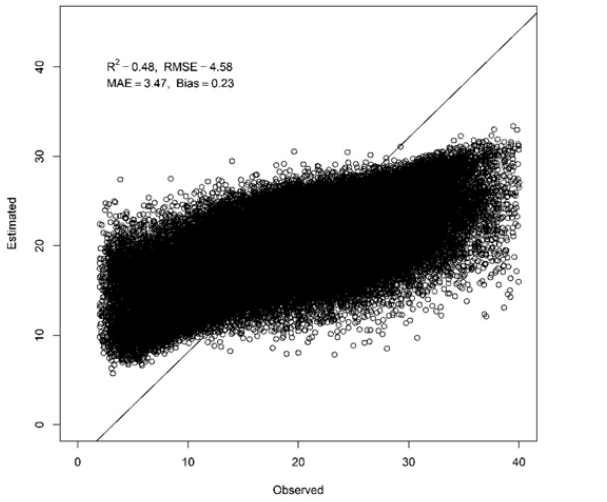
Figure 3. Importance of the predictor variables for estimating canopy height based on random forest.